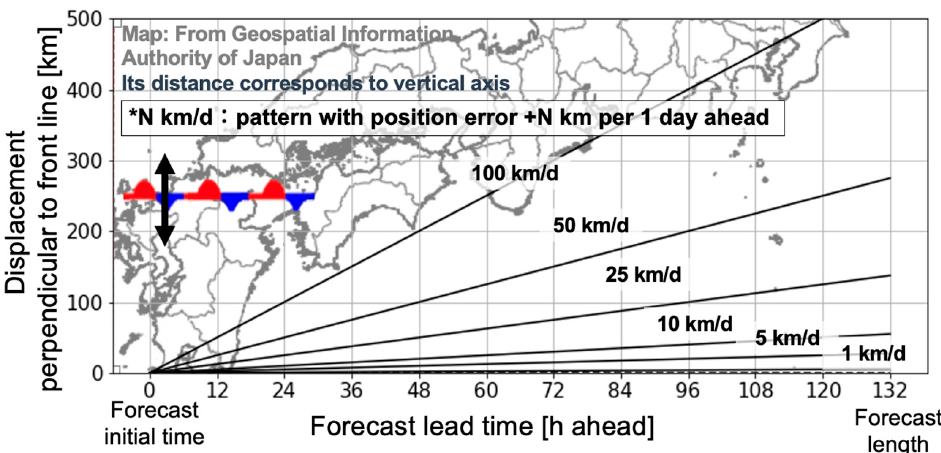
Figure 10. Forecast pa tt erns with displacements [km] of the rainfall zone perpendicular to front line. The vertical distance of the background map is the y-axis. N km/d: a pa tt ern with position error +N km per 1 day ahead.